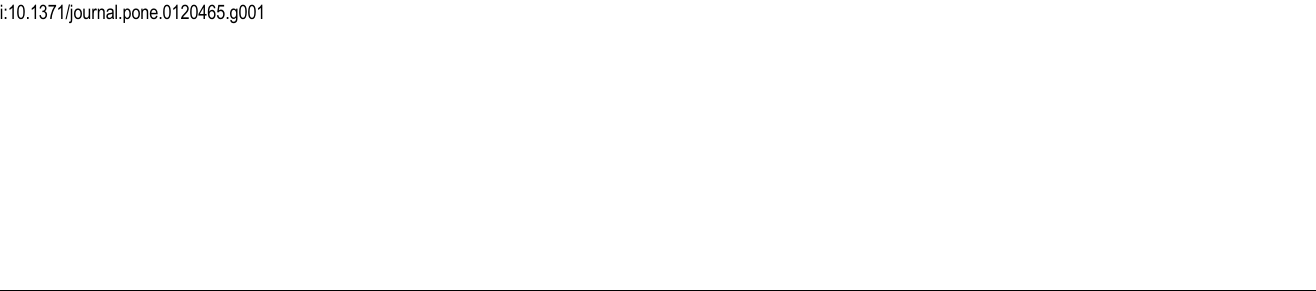
PLOS ONE | DOI:10.1371/journal.pone.0120465 April 7,